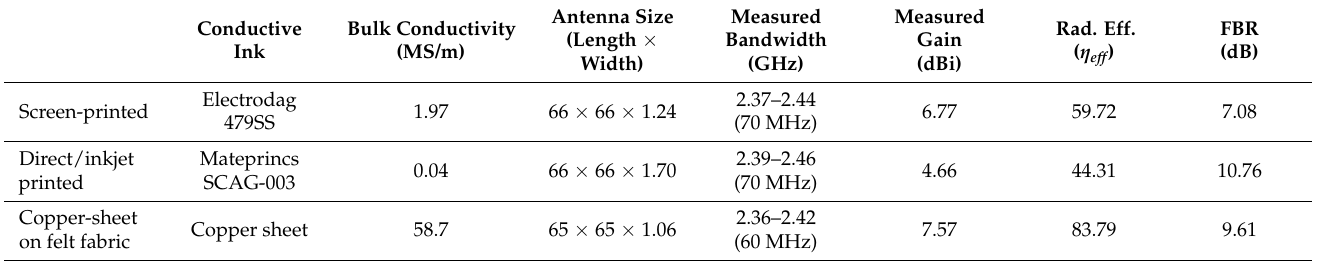
Table 1. Comparison of direct/inkjet printing vs. screen-printing of fabric patch antenna.